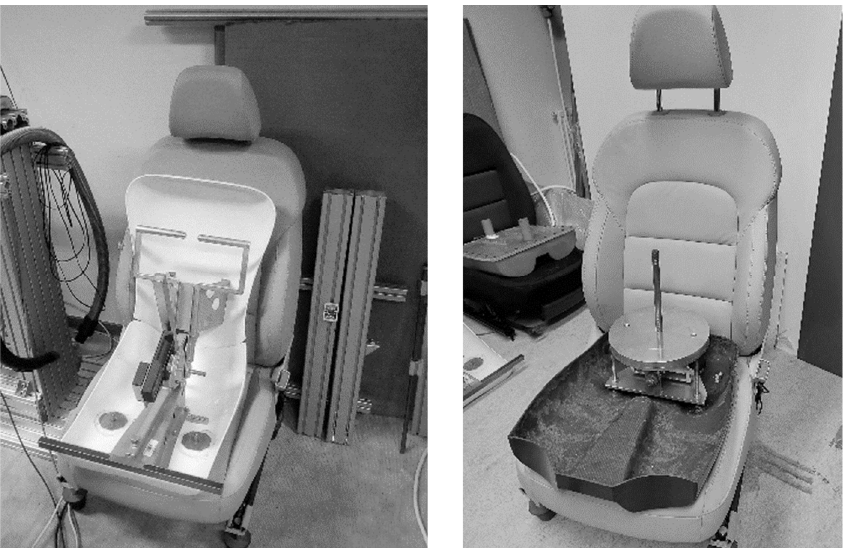
Figure 2. Original loading.